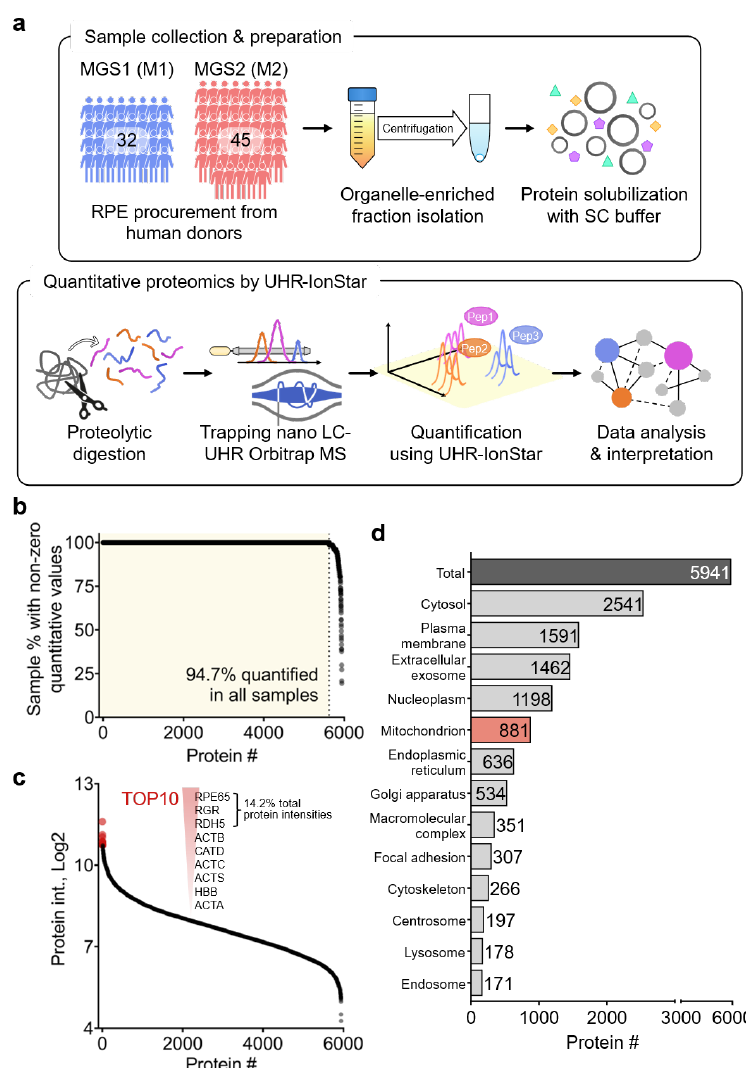
Figure 1. Proteomics profiling of RPE organelle-enriched fractions from human donors with AMD. ( a ) Experimental and data analysis procedures of the current study; ( b ) the percentage of proteins quantified with non-zero quantitative values (i.e., missing data-free) in the dataset; ( c ) ranked order of protein MS intensities and the TOP10 most abundant proteins. ( d ) Gene ontology (GO) enrichment of cellular component (CC) terms for the 5941 proteins quantified.